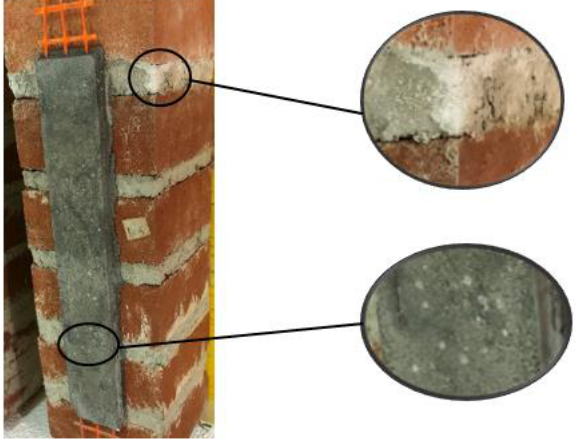
Figure 4. Salt efflorescence in specimen DS_300_50_G_W/D_5. Four different failure modes, illustrated in boxes (a) to (d) of Figure 3, were observed. They were named following the notation J z , where J indicates the failure mode ( D = debonding, R = fiber rupture, and M = mixed failure mode) and subscript Z